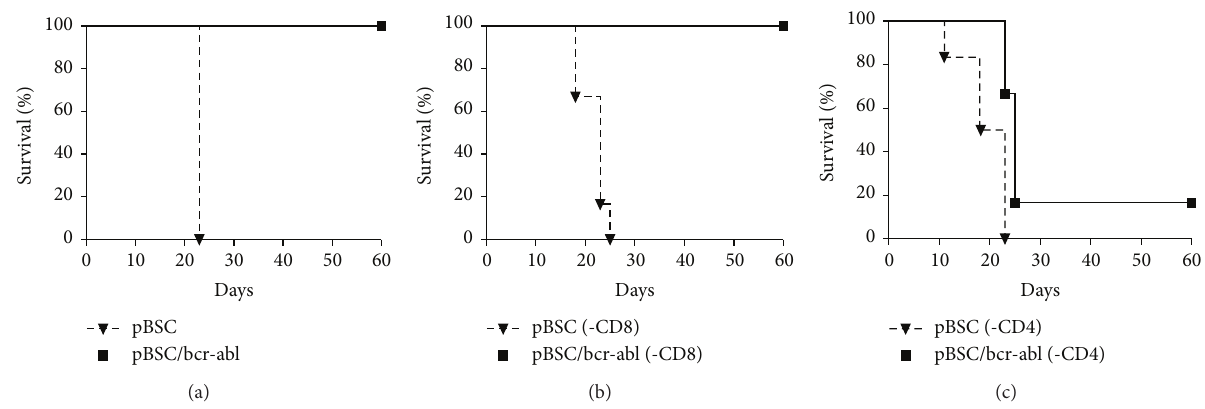
Figure 2: Survival of mice inoculated with empty pBSC or pBSC/bcr-abl plasmid and challenged with 12B1 cells. Six animals were in each group. (a) Nondepleted, (b) depleted of CD8+ T cells, and (c) depleted of CD4+ T cells.